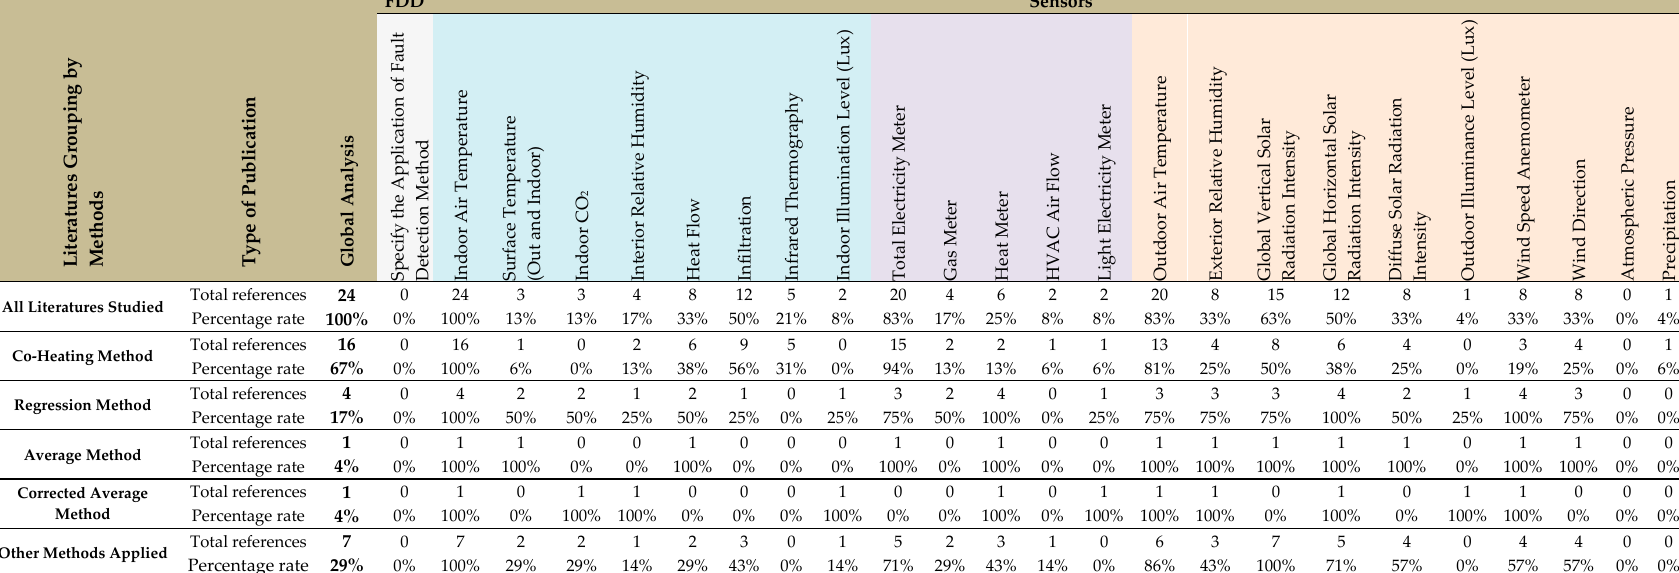
Table 14. Quantitative analysis of the references studied by methodology: Global analysis of the method used, the fault detection and sensor type used for measuring physical variables in the MCSs in each methodology.